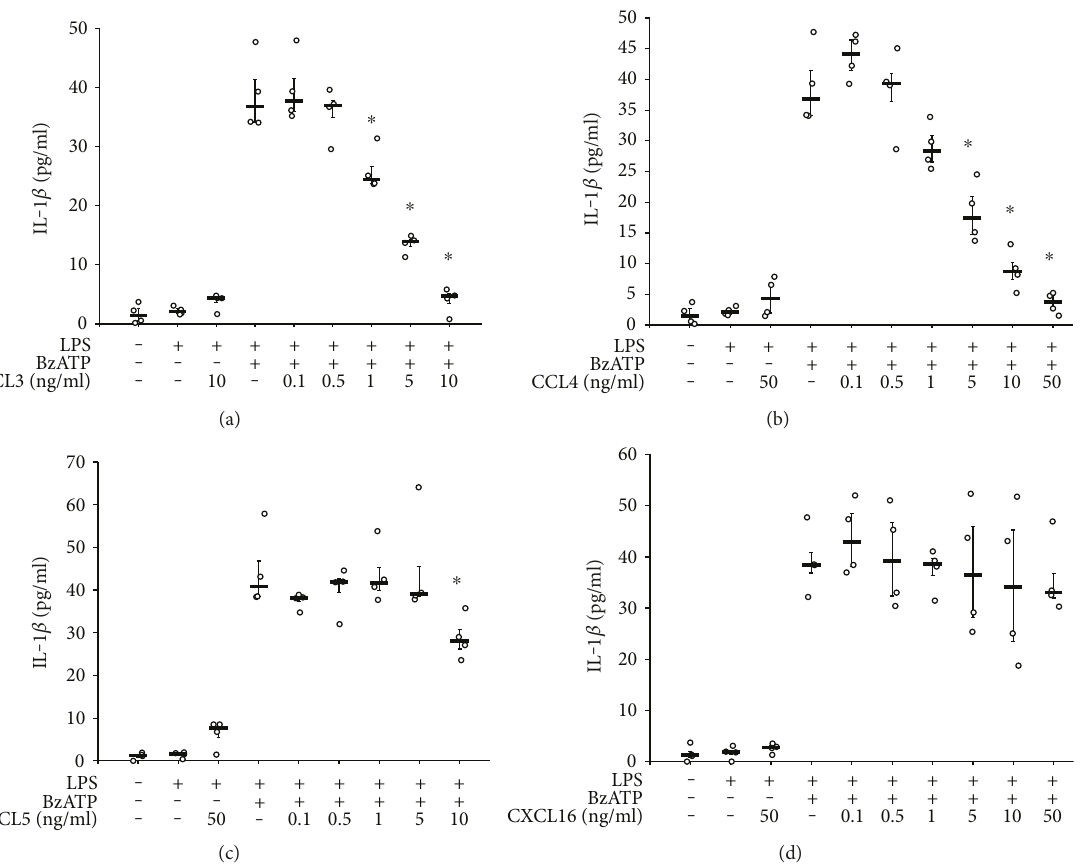
Figure 1: CCL chemokines inhibit ATP-induced IL-1 β release. (a) Human monocytic U937 cells were primed with LPS (1 μ g/ml, 5h) and activated with 2 ′ (3 ′ )-O-(4-benzoylbenzoyl)adenosine-5 ′ -triphosphate (BzATP; 100 μ M, 30min). The release of IL-1 β to the cell culture supernatant was measured by ELISA. Chemokines CCL3 (a), CCL4 (b), and CCL5 (c) dose dependently and e ffi ciently inhibited the BzATP-induced release of IL-1 β . In contrast, chemokine CXCL16 (d) was ine ff ective. Data are presented as individual data points, bars indicate median, and whiskers percentiles are 25 and 75; n = 4 ; ∗ p = 0 029 , in comparison to cells treated with LPS and